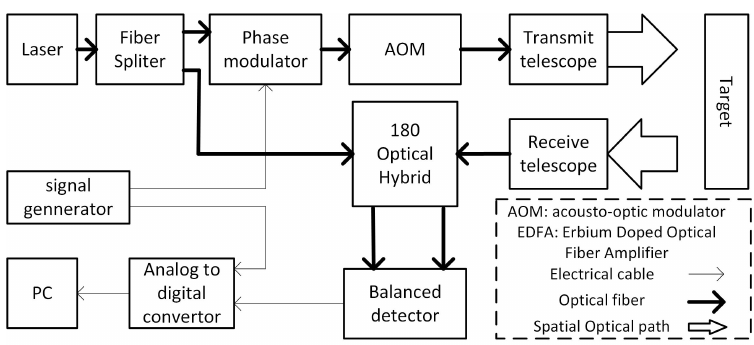
Figure 1. Diagram of the phase-shift laser ranging system based on multi-frequency carrier phase